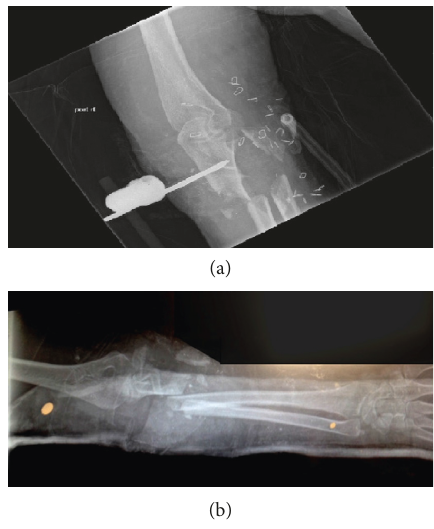
Figure 2: (a) AP X-ray after application of external fixator device demonstrating bony injury on initial injury after debridement. (b) AP X-ray showing the bony injury involving the ulna and radius, with a large amount of radial bone